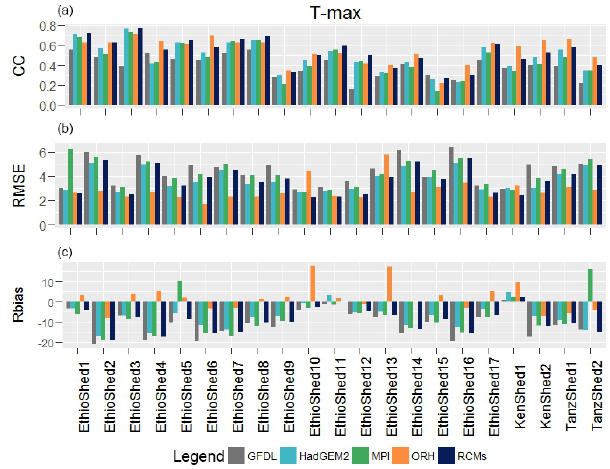
Figure 3. Statistical evaluation of daily rainfall retrieved from ARC2, CHIRP, CHIRPS, ORH, and RCMs against ground observa- tions: CC (a) , RMSE (b) , and R bias (c) during the period of 1983– 2005 for 21 validation areas of East Africa (see Table 1).